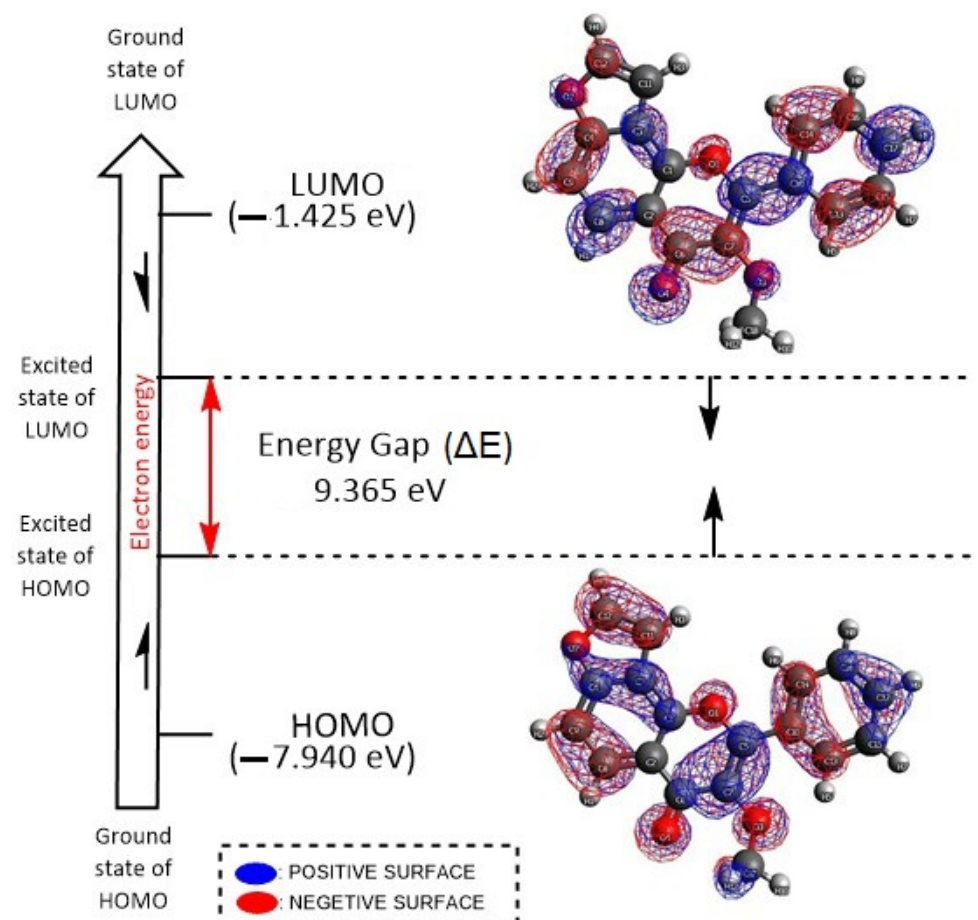
Figure 11. Frontier molecular orbitals (FMOs) analysis of karanjin in the form of LUMO, HOMO and their energy gap ( Δ E eV) using the software Avogadro.